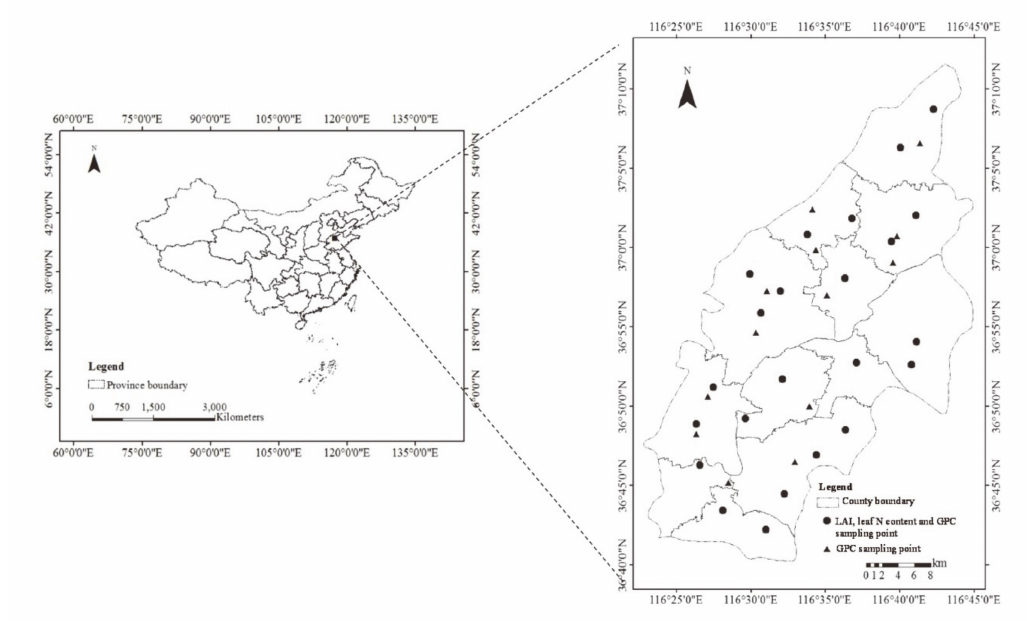
Figure 1. Study site and field sampling